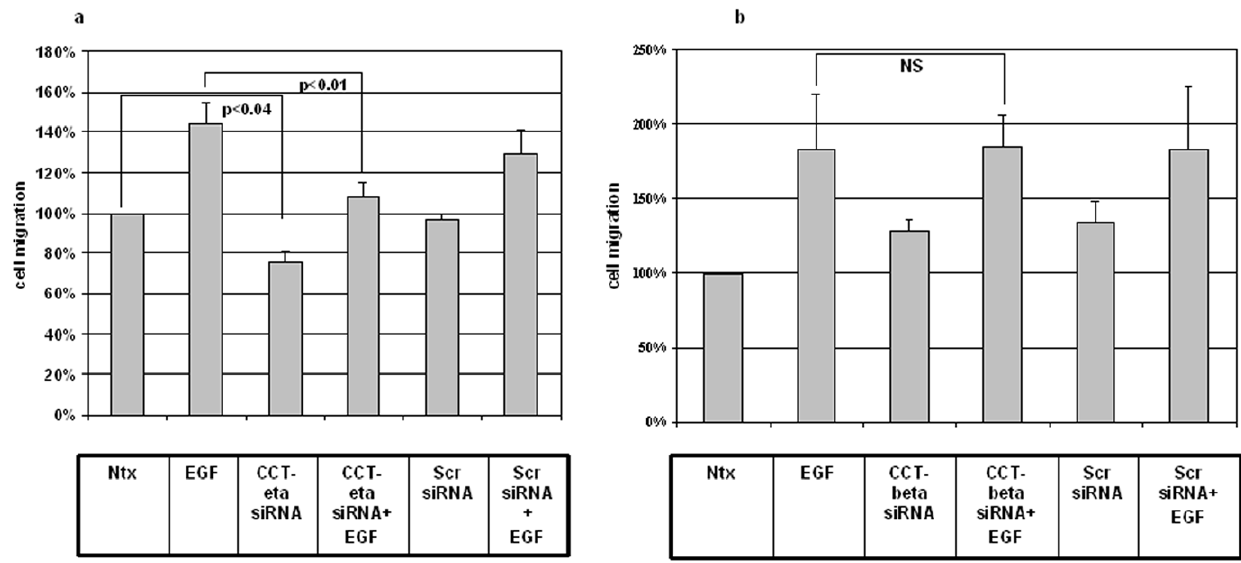
Figure 4. siRNA against CCT-eta decreases EGF - induced fibroblast migration, whereas siRNA against CCT-beta does not. Cells were incubated in the presence or absence of EGF(1 nM) + / 2 siRNA against CCT-eta (a) or CCT-beta (b) in an in vitro wound healing assay. In all experiments a subunit -specific scrambled siRNA sequence was used as control. Cell motility is displayed as a relative percentage of baseline motility in the absence of EGF or siRNA exposure (100%). Active siRNA versus CCT-eta reduced both basal and EGF-induced motility; siRNA versus CCT-beta and scrambled controls had no effect. Values are means 6 SEM of six independent studies, each performed in triplicate. Statistical analyses were performed with Student’s t test.